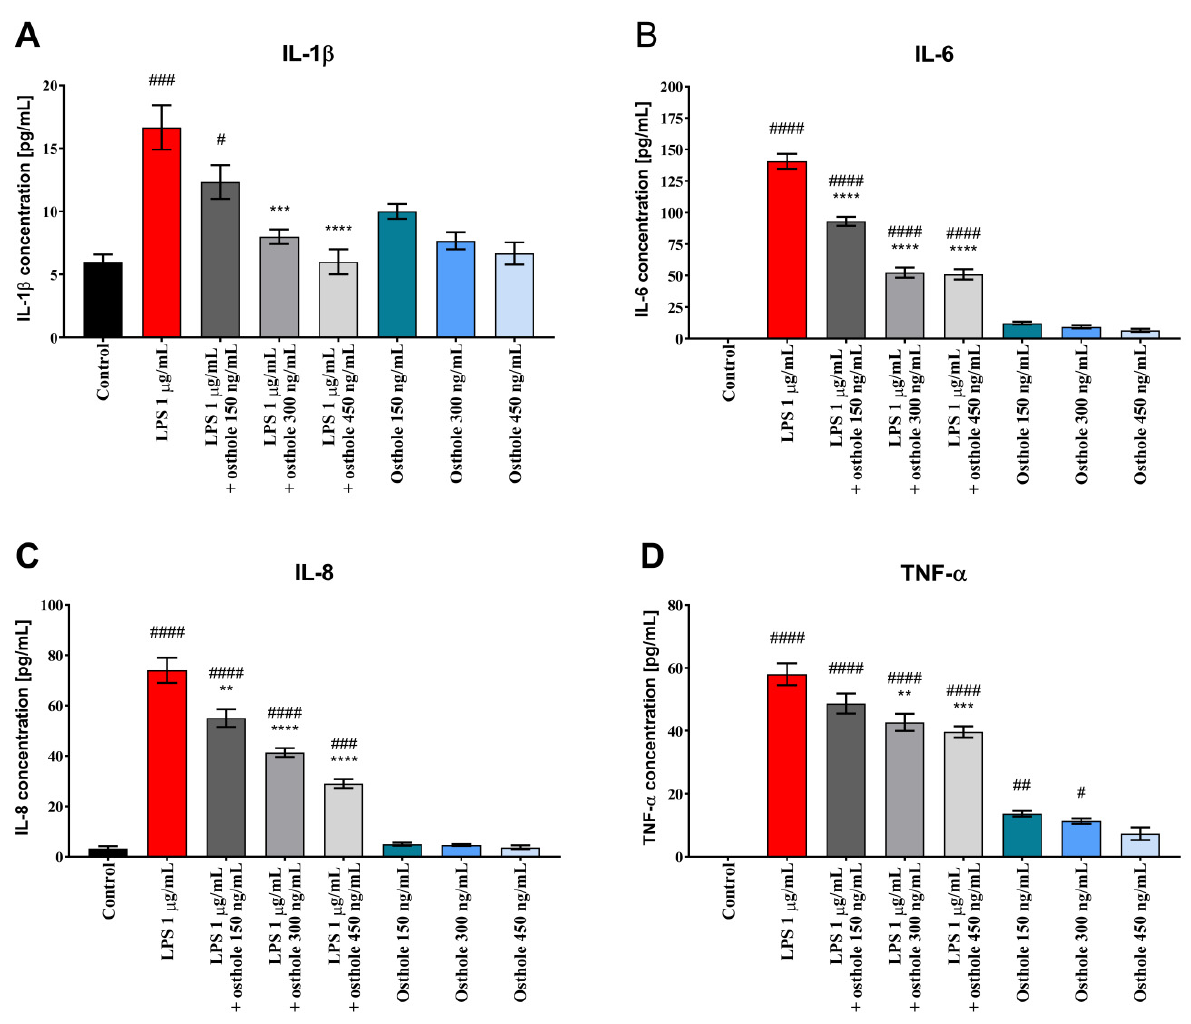
Figure 3. The level of IL-1 β ( A ), IL-6 ( B ), IL-8 ( C ) and TNF- α ( D ) in Caco-2/THP-1 co-culture after incubation with LPS (1 µ g/mL), osthole (150–450 ng/mL) and its mixtures. Horizontal line shows mean and bars depict standard error of mean. Statistically significant differences in comparison to control (#— p < 0.05, ##— p < 0.01, ###— p < 0.001, ####— p < 0.0001) and to cells treated with LPS (**— p < 0.01, ***— p < 0.001, ****— p < 0.0001) are marked.